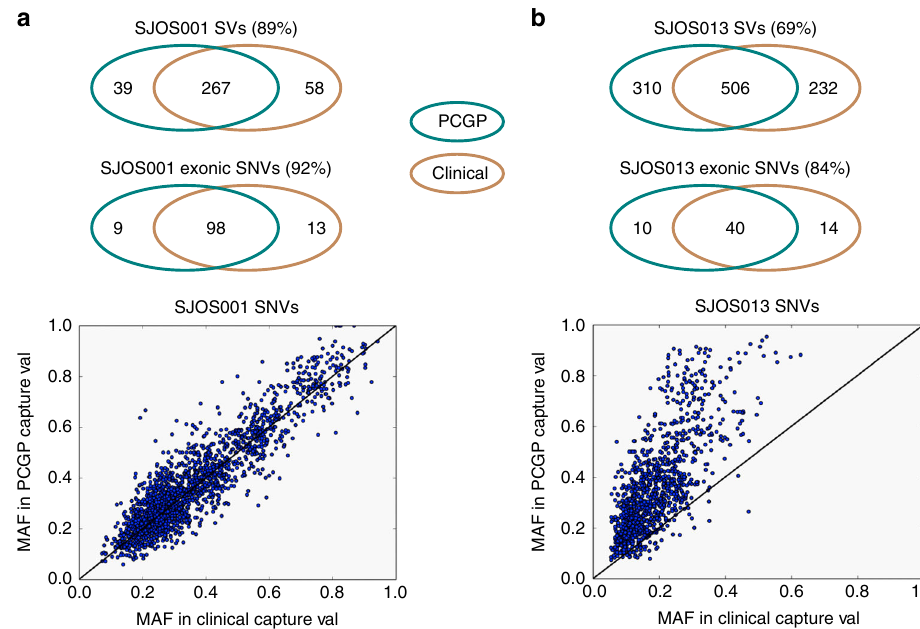
Fig. 4 Comparison of clinical-PCGP concordance of two osteosarcoma cases. For each case, two venn diagrams show overlap between PCGP calls and clinical calls, and a scatter plot compares the SNV MAF obtained by capture validation performed during the present clinical study (x-axis) and previously by the PCGP validation lab (y-axis). The SNVs used for a MAF plot included both exonic and non-exonic variants. The tumor samples used for both cases were different than the tumor samples in PCGP, and both showed lower-than-average sensitivity. a MAFs from SJOS001 SNV calls in PCGP and Clinical were highly correlated, and the SVs and exonic SNVs showed higher correlation. b The lower tumor purity of the SJOS013 clinical sample is re fl ected in the MAF distribution. Differences between the PCGP and clinical samples in this case reduced the measured